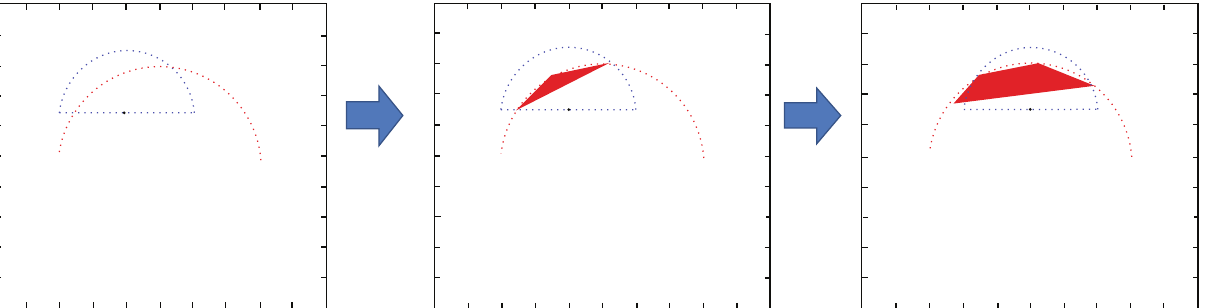
Figure 10: Agent Redefining a Large, Concave Obstacle.